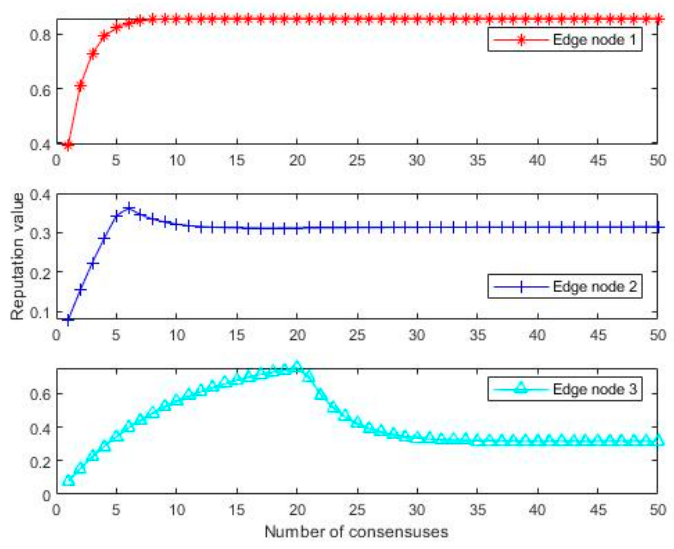
Figure 6. Reputation change process.